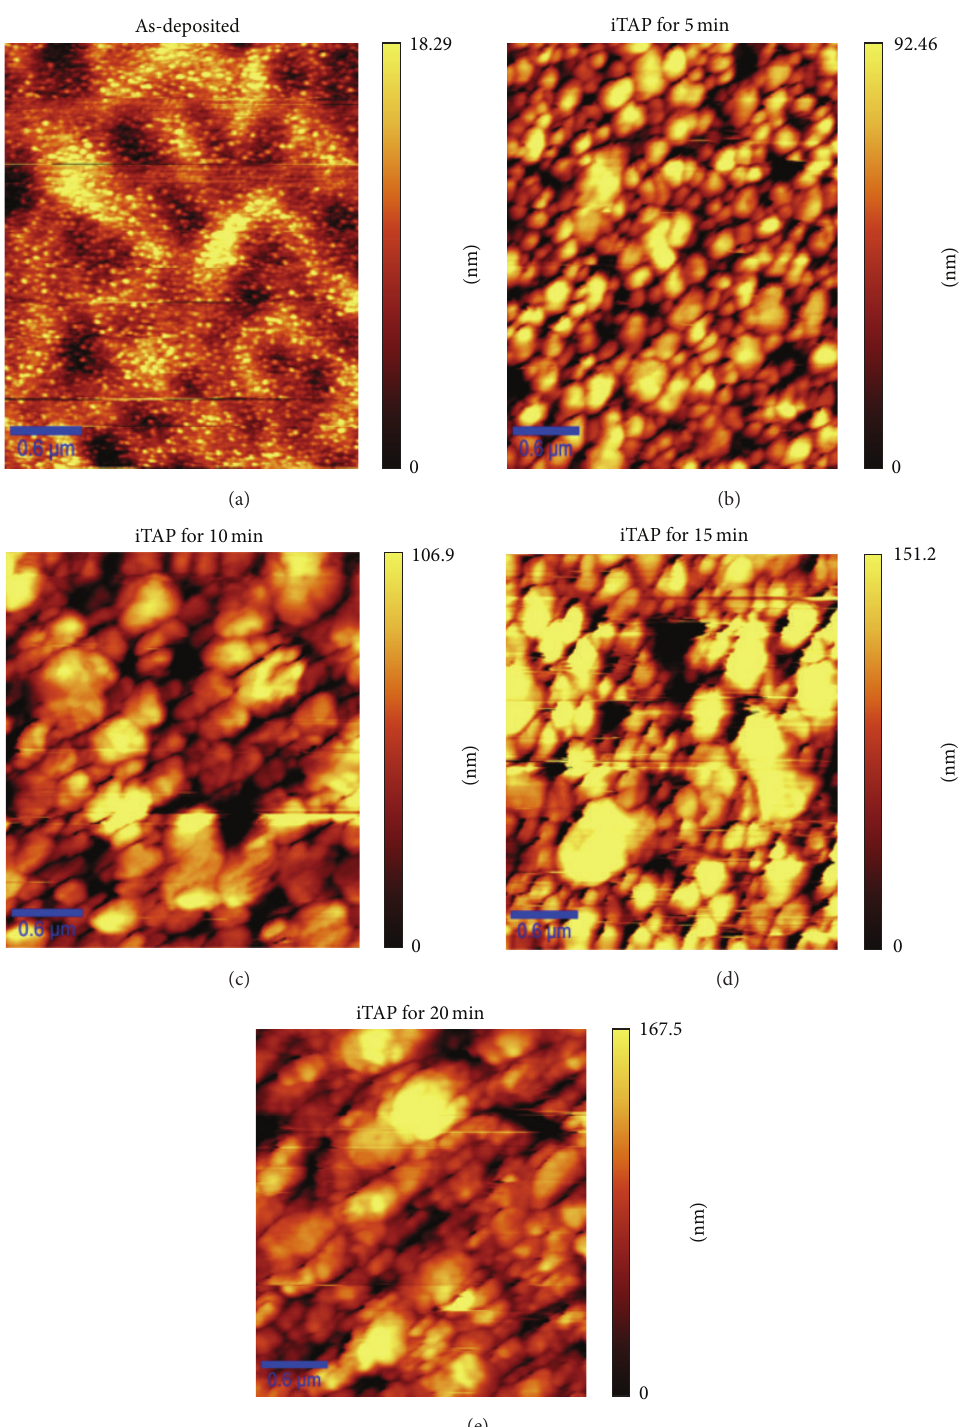
Figure 3: AFM images taken on CdTe films, as-deposited (a), and with iTAP at 450 ∘ C for durations of 5min. (b), 10min. (c), 15 min. (d), and 20 min.